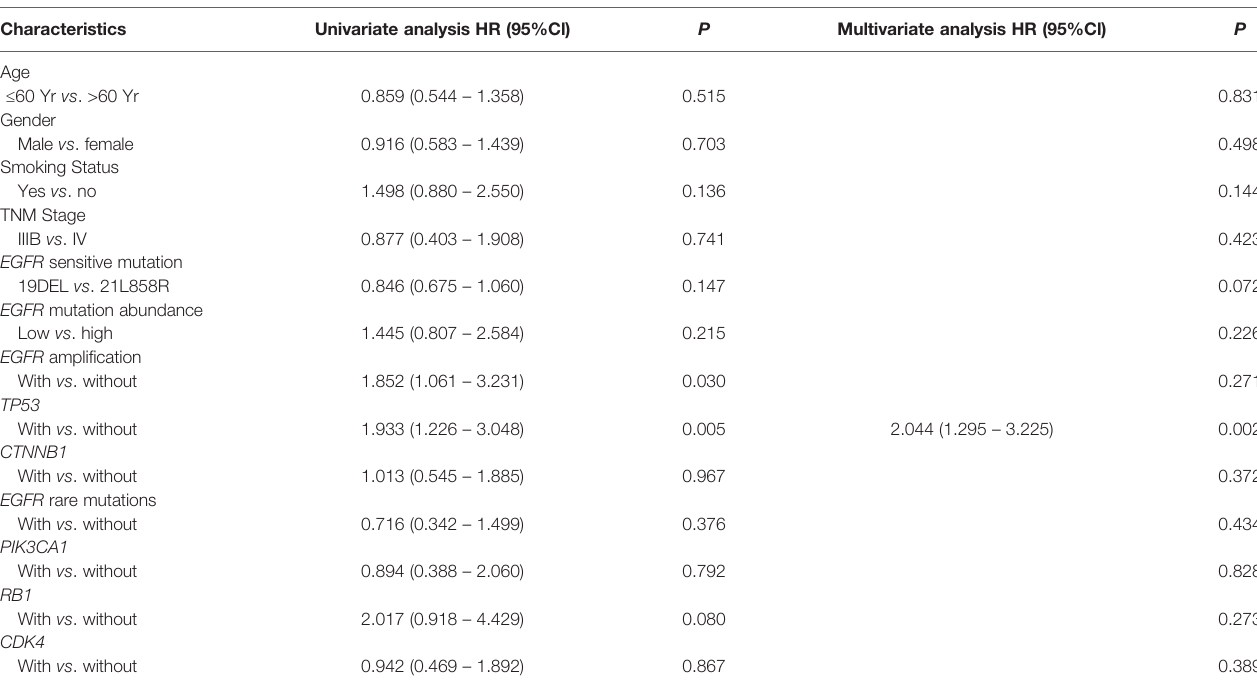
TABLE 2 | Univariate and multivariate analysis for PFS in monotherapy group. PFS Characteristics